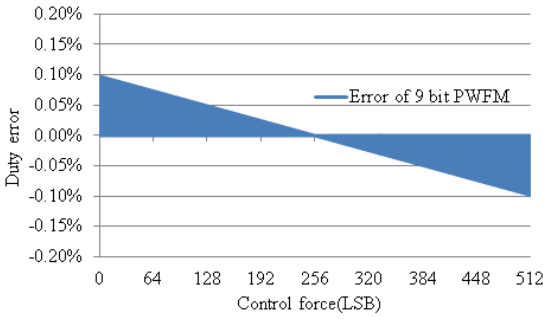
Figure 9. Curves of duty cycle error versus control force for the PWFM strategy.